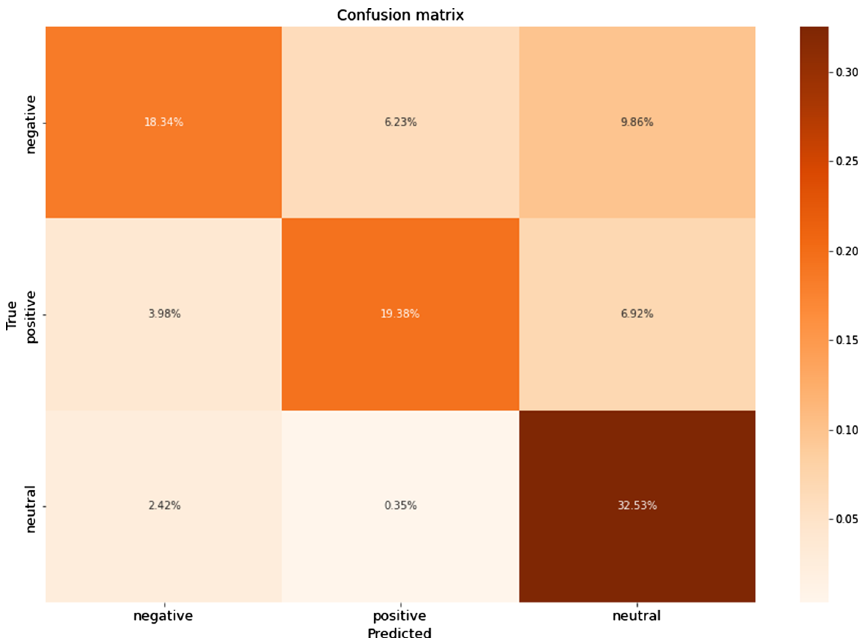
Fig. 21 A confusion matrix for Kazakh texts of a DT algorithm